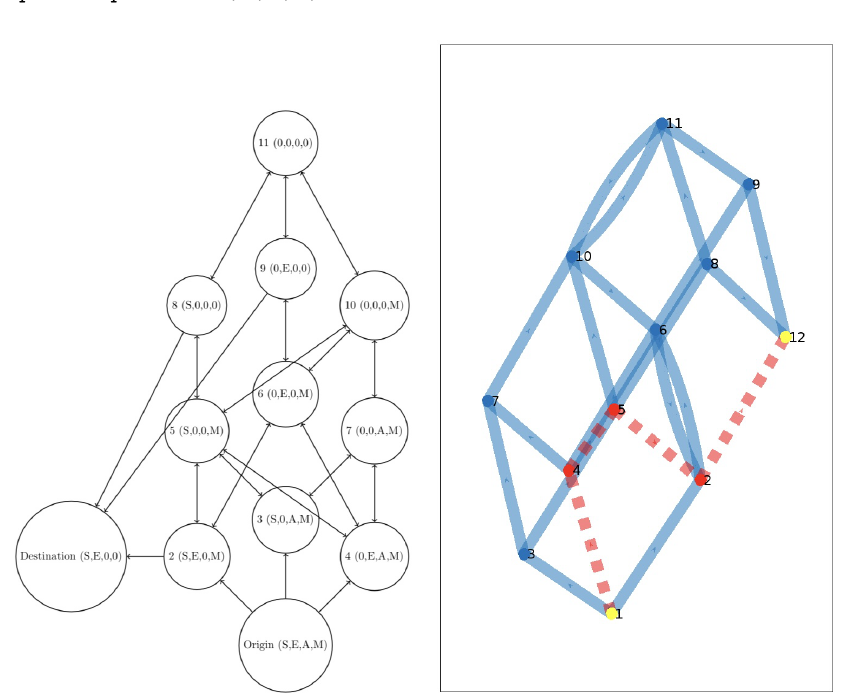
Figure 10. ( Left ): the graph of the ecosystem’s equilibria of [33]. ( Right ): the optimal path